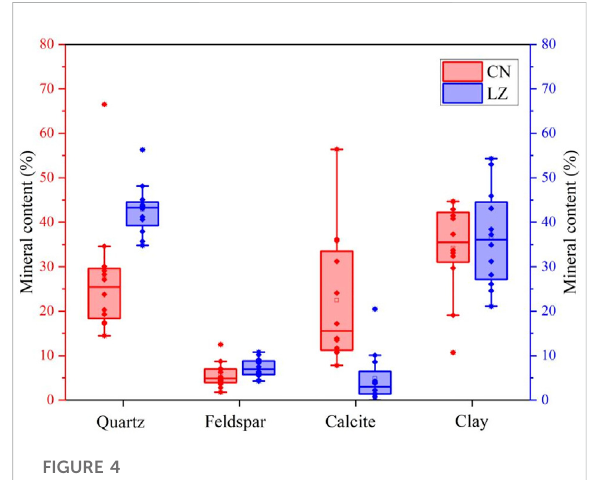
FIGURE 4 Box plot of mineral content in the Longmaxi Formation shale in the study